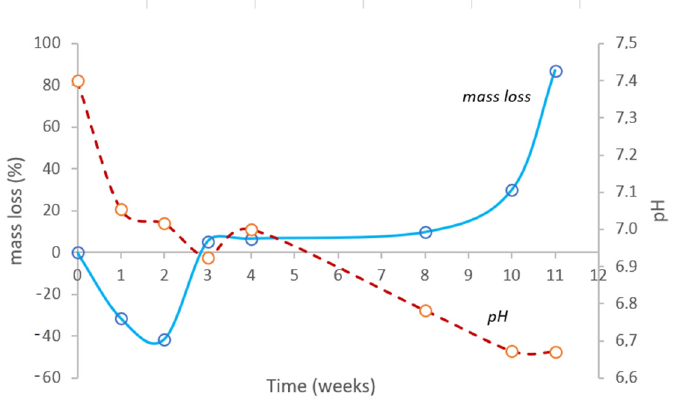
Figure 7. In vitro degradation under accelerated physiological conditions (PBS solution, 40 °C, RH = 75%) represented by mass loss. pH variation of solution is represented by the dash line.